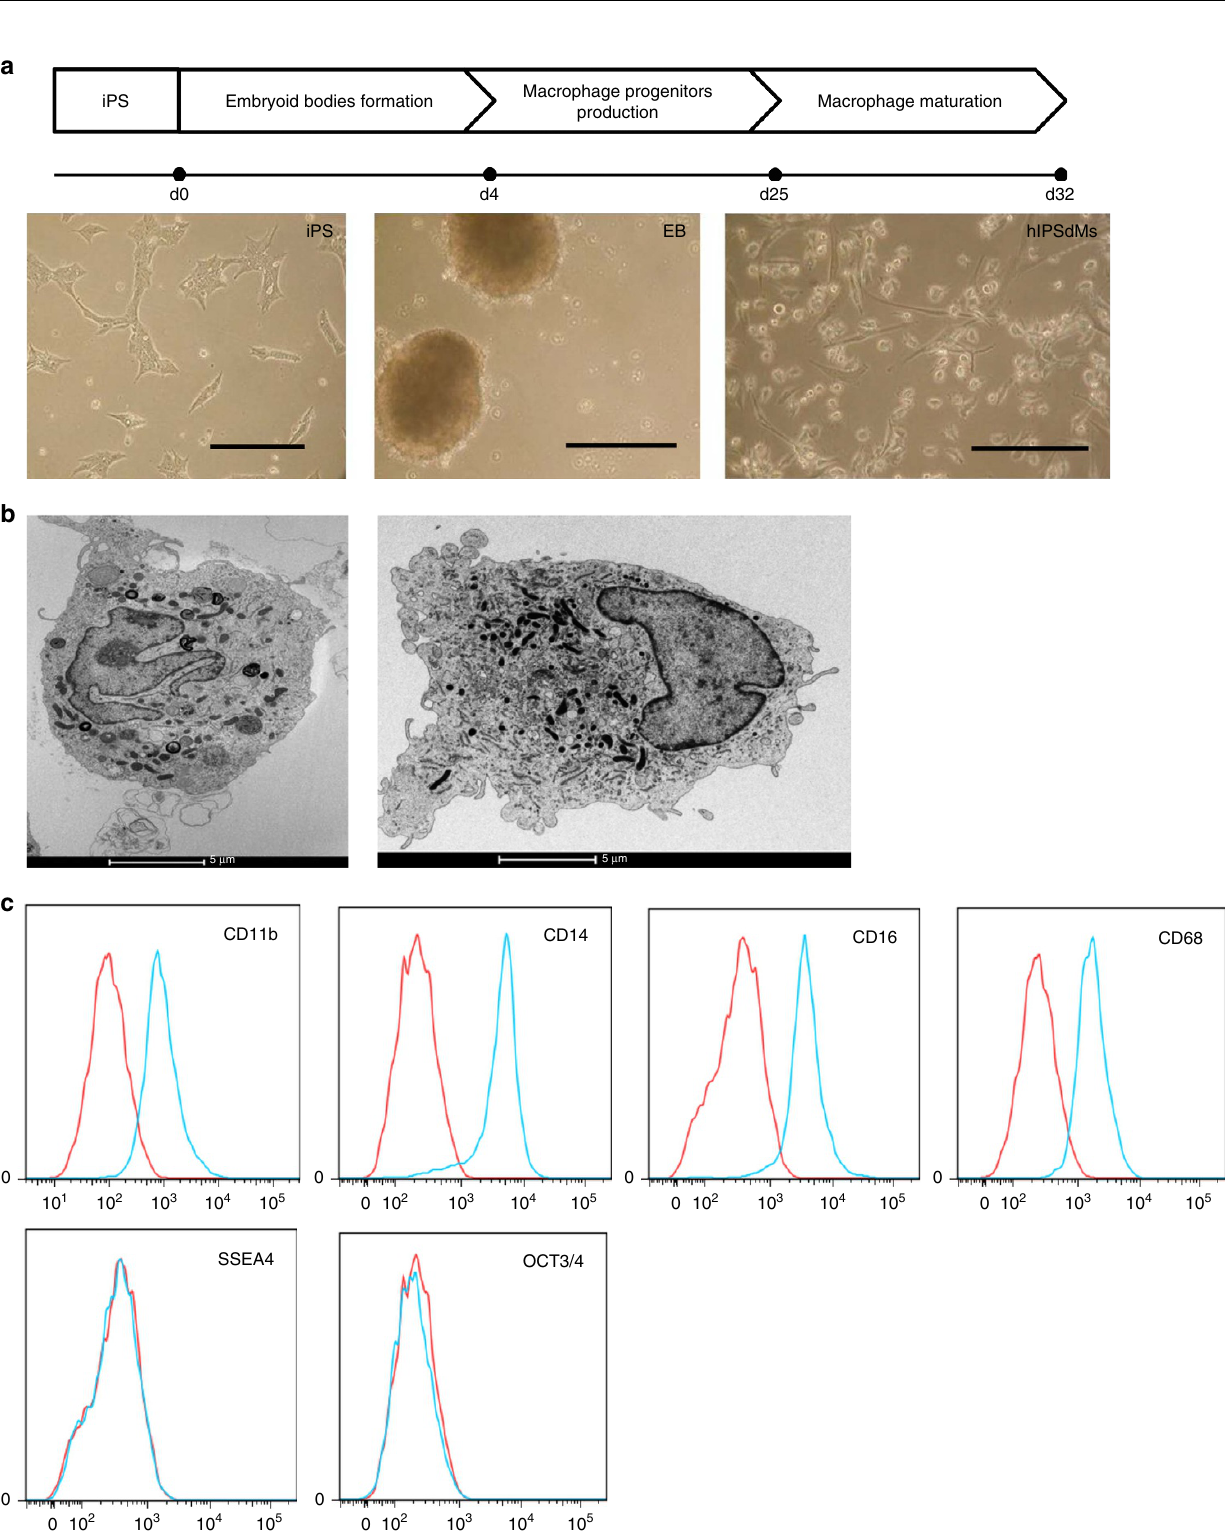
Figure 1 | Differentiation of macrophages from human iPSCs. ( a ) Schematic diagram of the method of in vitro differentiation from human iPSCs to macrophages, with accompanying representative light microscopy images for each stage. Scale bars, 200 m m. ( b ) EM images of a human iPSdM (left) and a human blood monocyte differentiated macrophage (right). ( c ) Flow cytometry analyses for the expression of macrophage markers (CD11b, CD14, CD16, CD68) and pluripotency markers (SSEA4, OCT3/4) on human iPSdMs. Red lines represent cells stained with control isotype and blue lines represent cells stained with the relevant